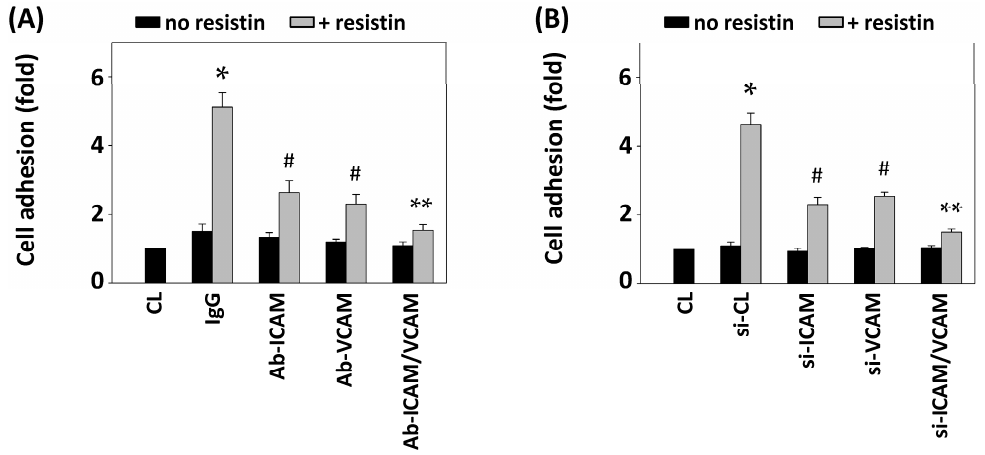
Figure 3. Blocking ICAM-1 and VCAM-1 in HCT-116 cells inhibits their adhesion to HUVECs. HCT-116 cells were pretreated with specific neutralizing antibodies ( A ) or siRNAs ( B ) for control (IgG/si-CL), ICAM-1, VCAM-1, or both and then were maintained as control or stimulated with resistin. HCT-116 cell adhesion was determined. Data represent the mean ± SEM from four independent experiments. * p < 0.05 vs. control cells (CL); # p < 0.05 vs. cells pretreated with IgG or si-CL and then treated with resistin only; ** p < 0.05 vs. cells pretreated with ICAM-1 or VCAM-1 neutralizing antibody and then treated with resistin.